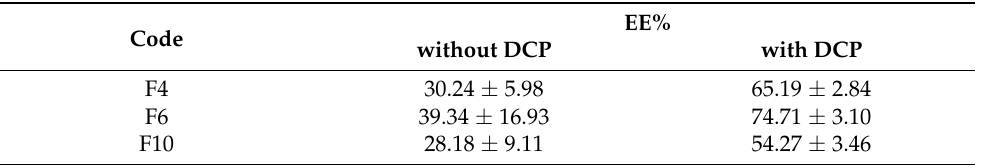
Table 4. Comparison of EE% of niosomal formulations (F4, F6 and F10) with and without DCP. Results are represented by mean ± SD ( n =